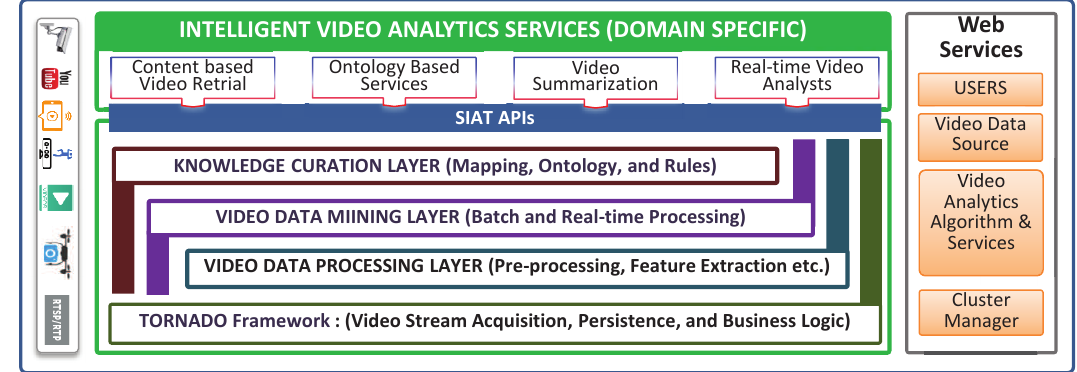
Figure 1. SIAT (ongoing collaborative research project) architecture.